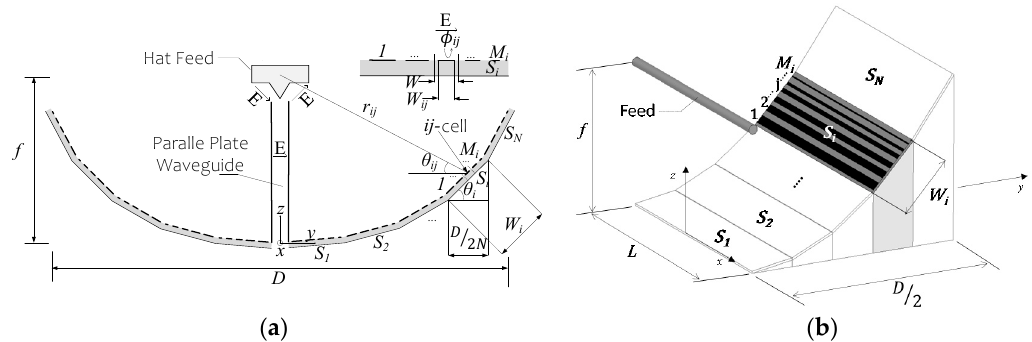
Figure 1. Paneled cylindrical reflectarray geometry: ( a ) Section view of the entire geometry; ( b ) 3-D view of half structure.